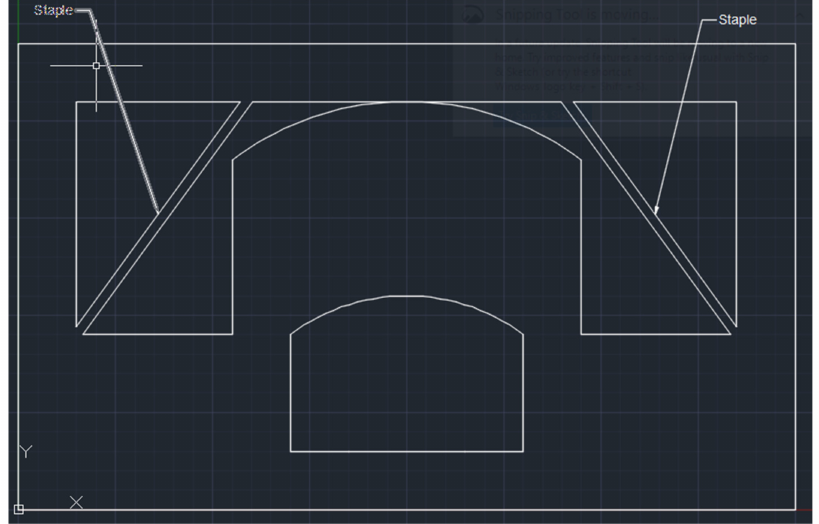
Figure 13. SQ4D Typica wall configuration